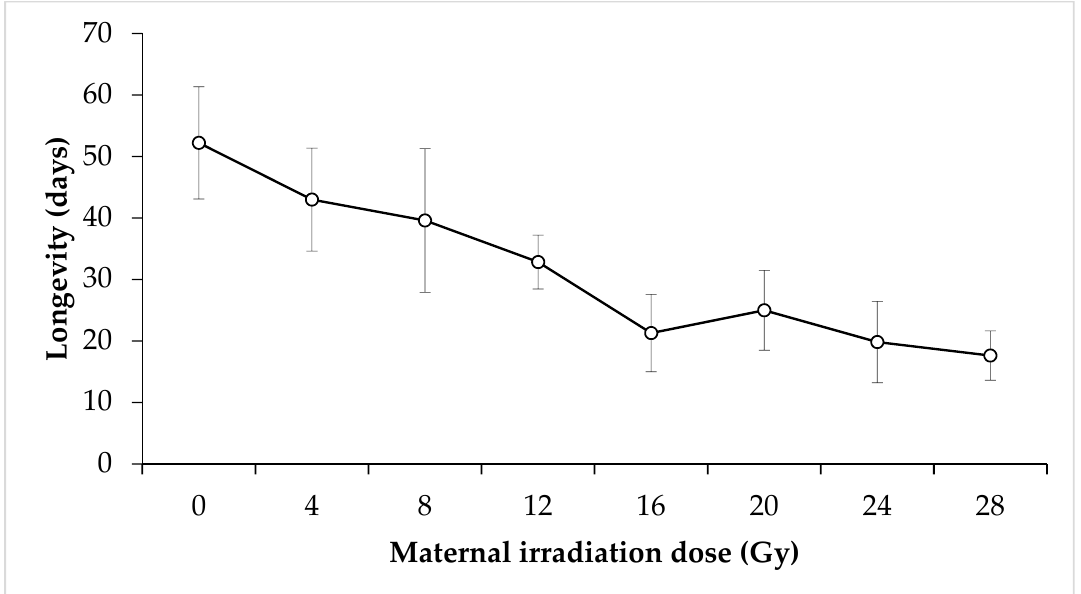
Figure 7. Mean longevity of irradiated female Nezara viridula that were crossed with untreated males. Error bars show standard error.